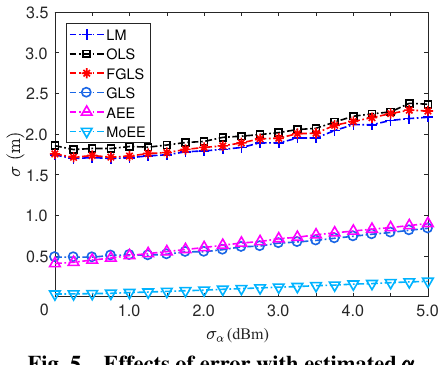
Fig. 3 Effects of measurement error with non-IID error.